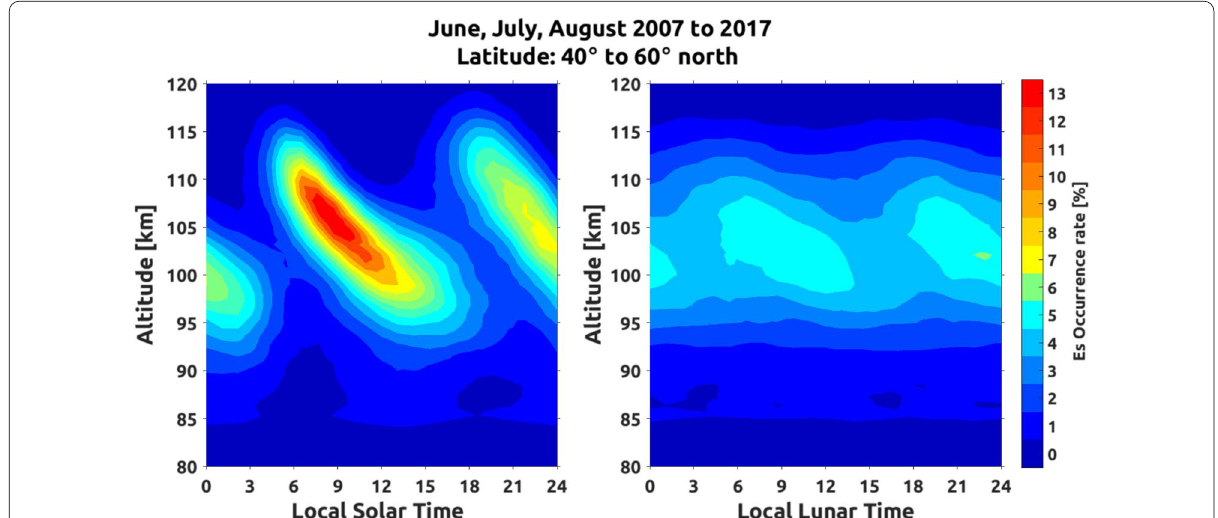
Fig. 1 Mid‑latitude EsOR variations during northern hemisphere summer with solar local time (left) and lunar local time (right) at different